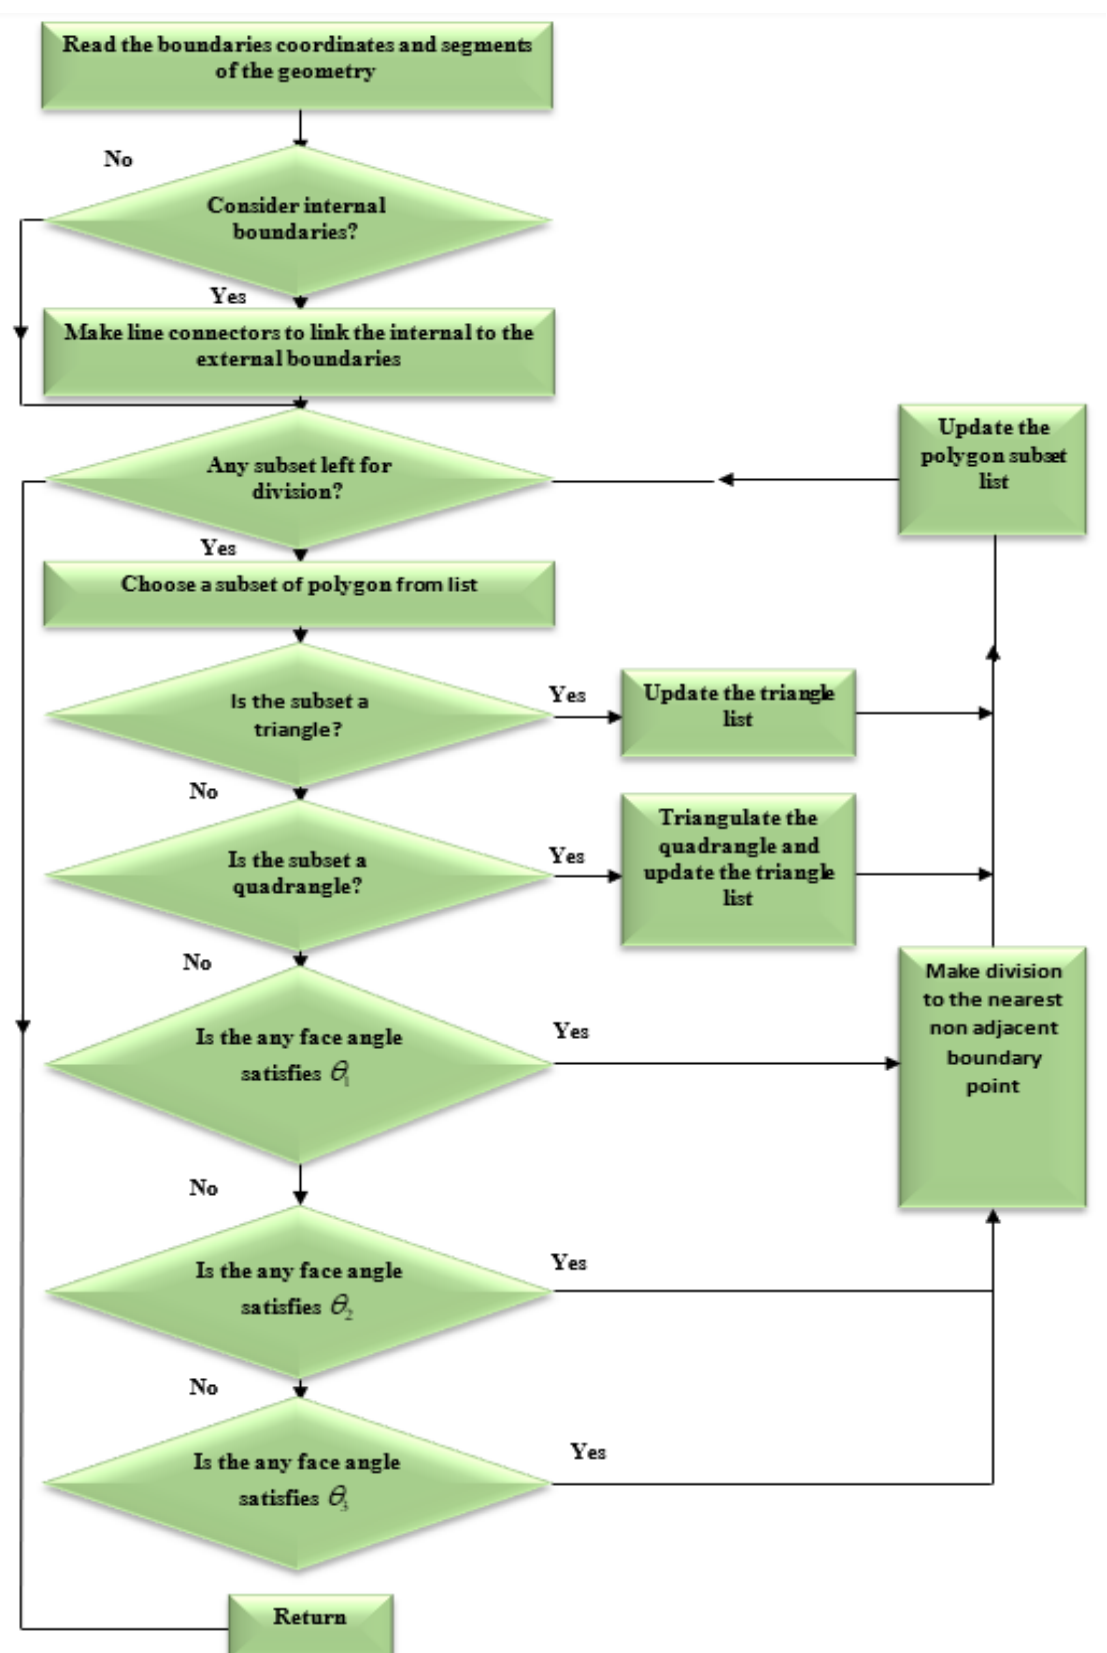
Figure 4. Flowchart of the background mesh generation.